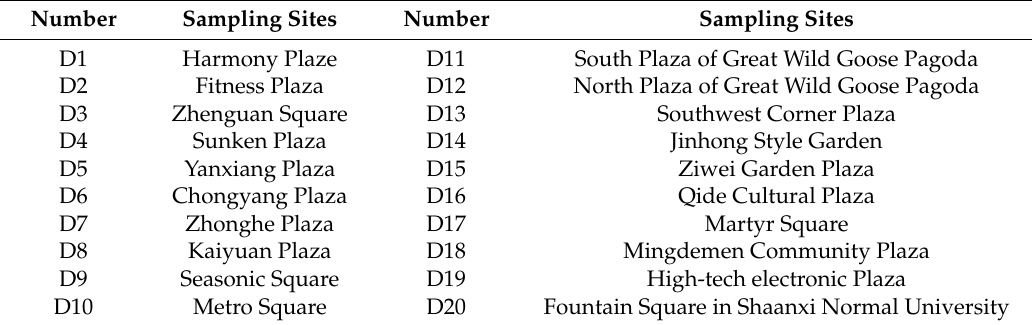
Table 1. Sampling sites and symbolic